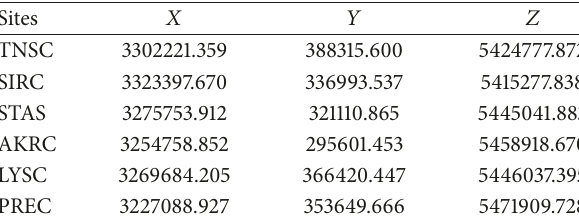
Table 3: Reference receiver coordinates, Euref89 𝑋𝑌𝑍 .